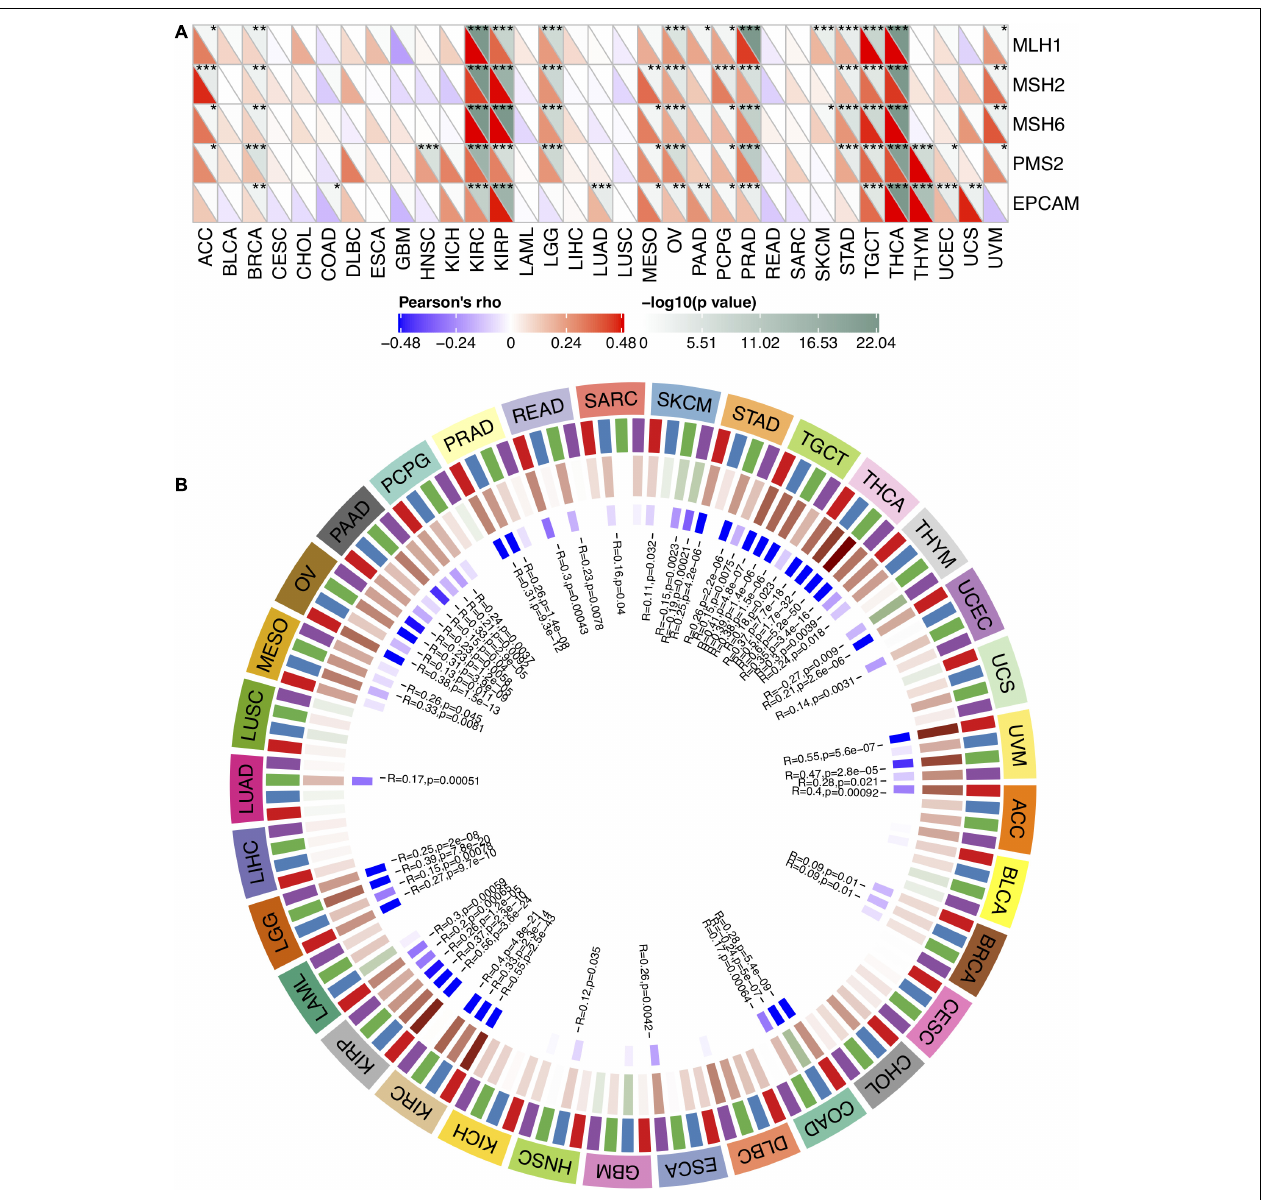
FIGURE 2 | In human pan-cancer, the expression levels of FURIN correlate with expression levels of five MMR genes and four DNA methyltransferases. (A) The Spearman’s correlation analysis of FURIN expression with expression levels of five MMR genes across cancers (* p < 0.05, ** p < 0.01, *** p < 0.001). (B) The Spearman’s correlation analysis of FURIN expression with four DNA methyltransferases across cancers.